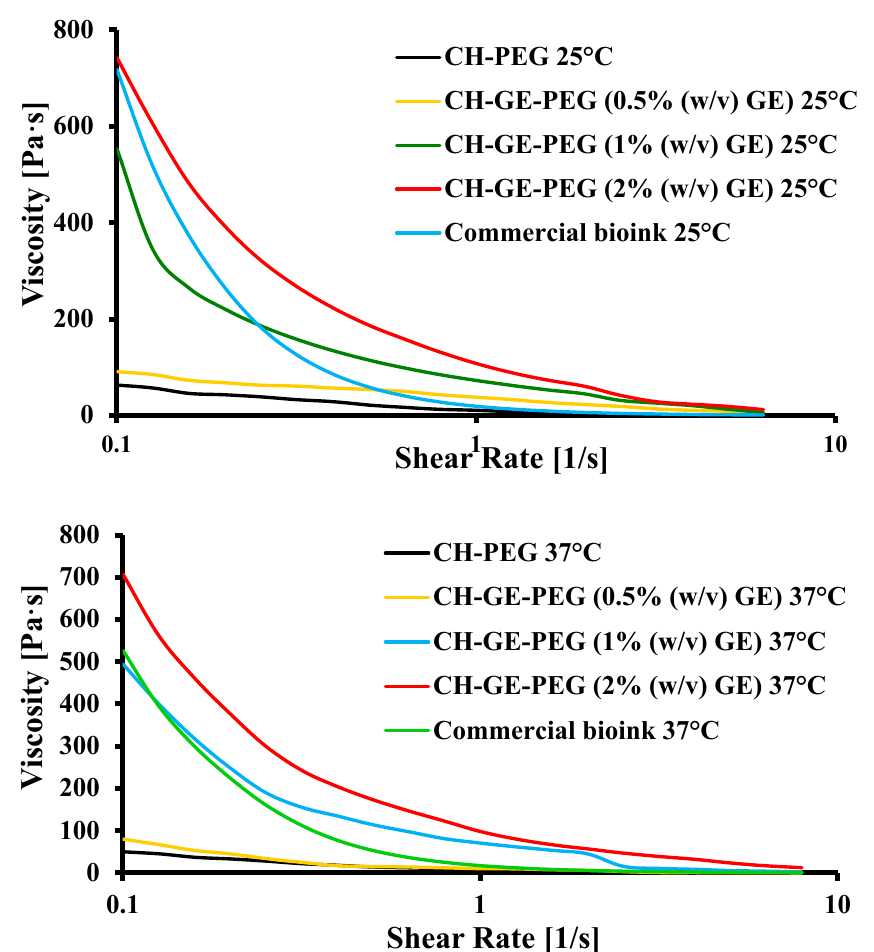
Figure 2. Rheological characterisation of hydrogels; CH–PEG, CH–GE–PEG having different GE% (0.5, 1, 2) and commercial bioink at 25 °C and 37 °C. Table 2. Rheological properties of crosslinked CH–GE bioinks at various GE concentrations ( n = 3 , ±